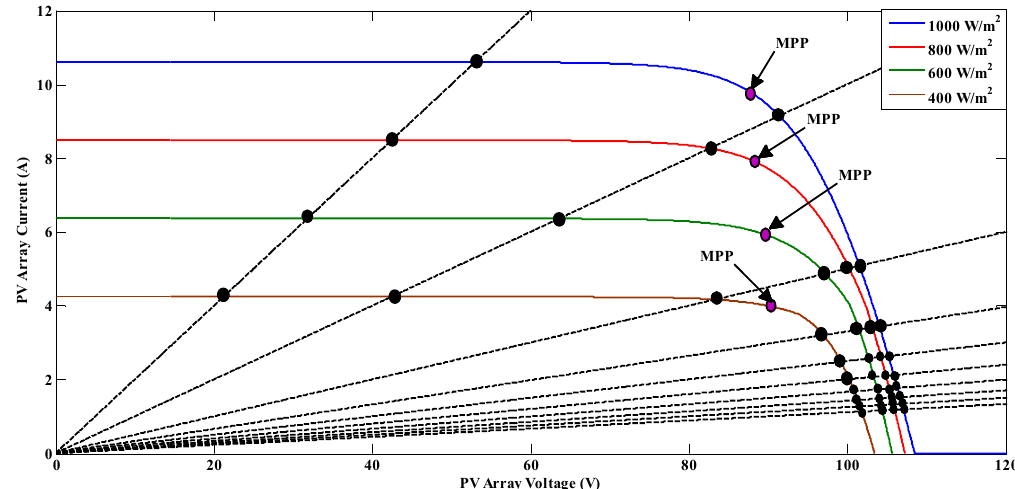
Figure 4. The operating points for different irradiations under uniform conditions.